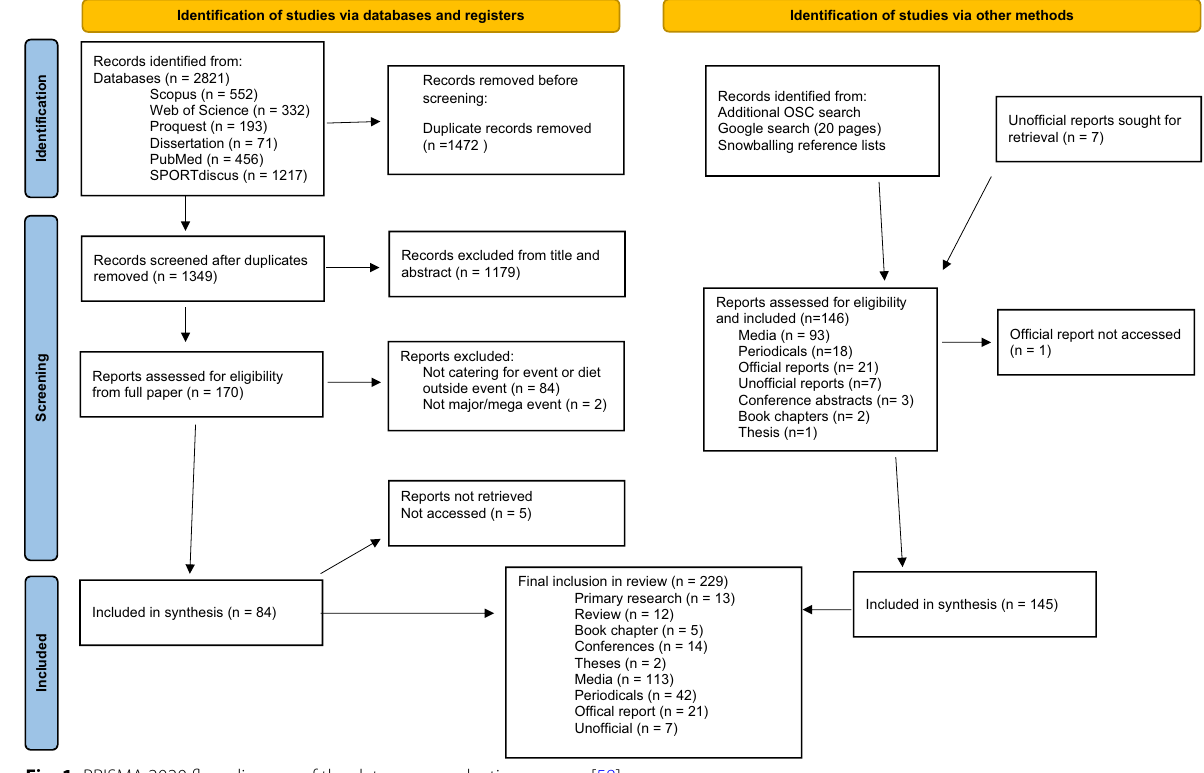
Fig. 1 PRISMA 2020 flow diagram of the data source selection process [58]